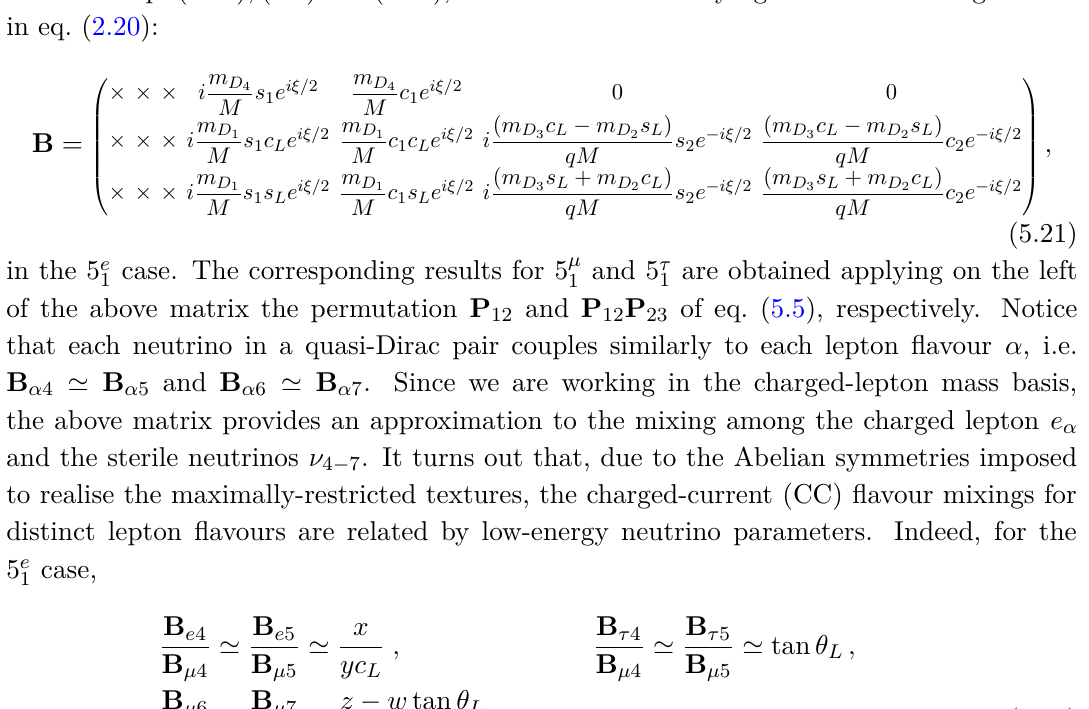
From eqs. (2.19), (5.4) and (5.18), we obtain for the heavy-light neutrino mixing